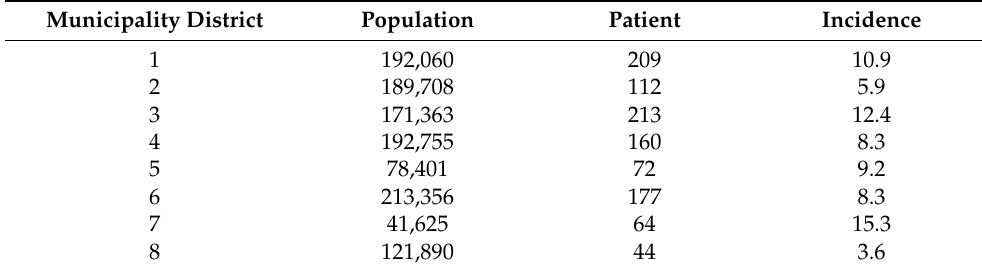
Table 4. Incidence rate in every municipality district.